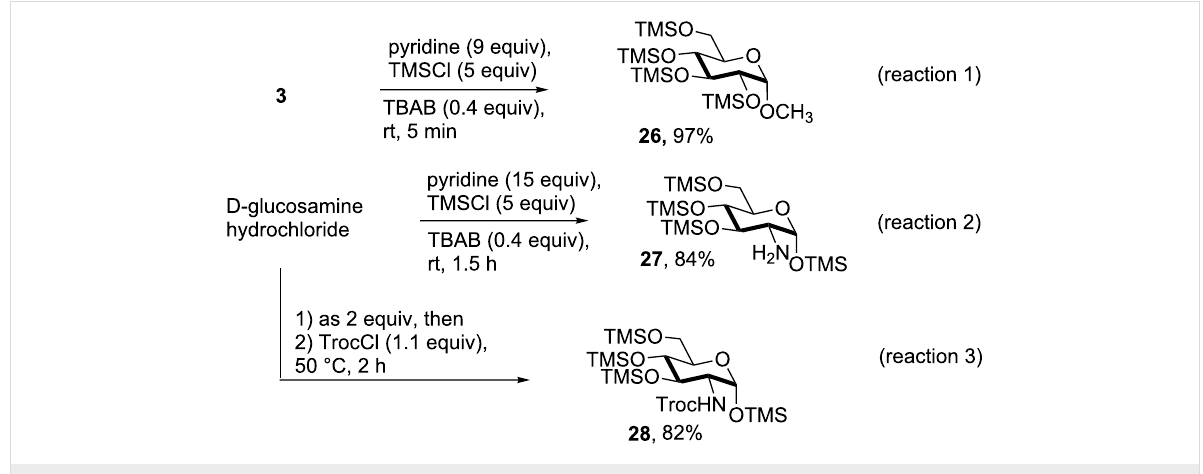
Scheme 1: Multiple O -trimethylsilylations of saccharide